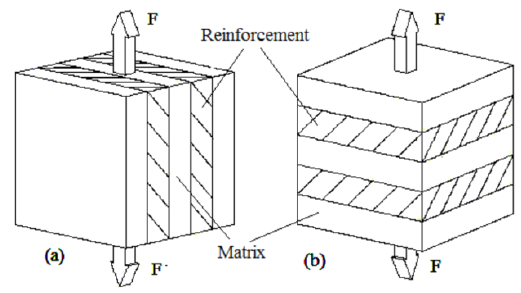
Figure 6. ( a ) Voigt iso-strain model; ( b ) Reuss iso-stress model.